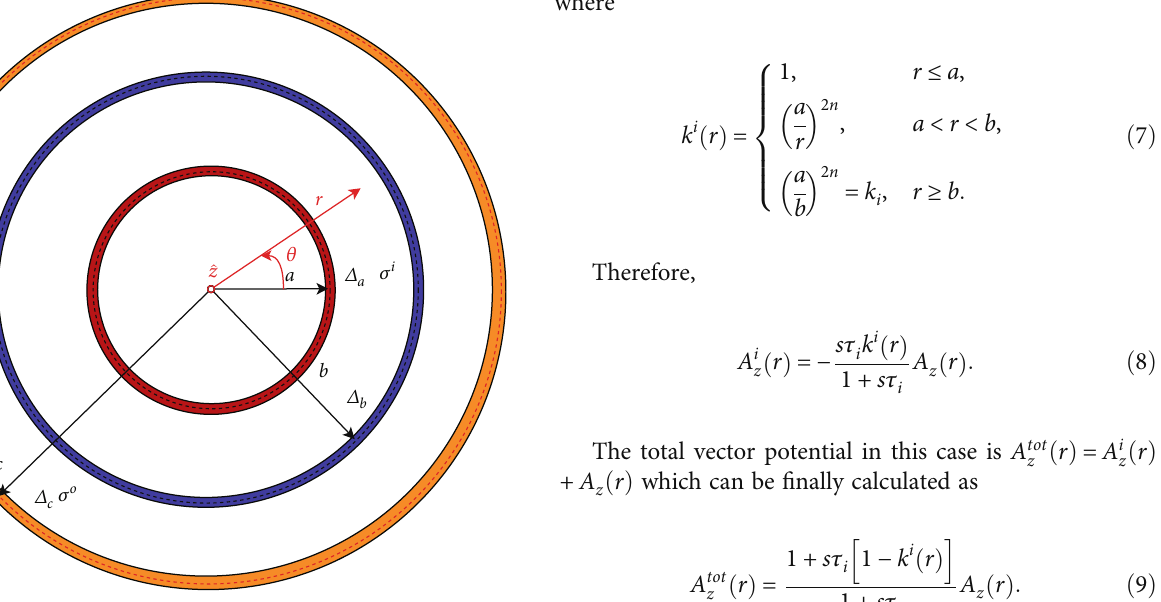
Figure 1: Simpli fi ed cross-section (not to scale) of an ideal superconducting magnet with superimposed adopted cylindrical coordinates): coils are located at r = b , an inner conductive shell (beam screen or vacuum pipe for example) is located at r = a , and an outer conductive shell (stainless steel or Al collar as an example) is located at r = c